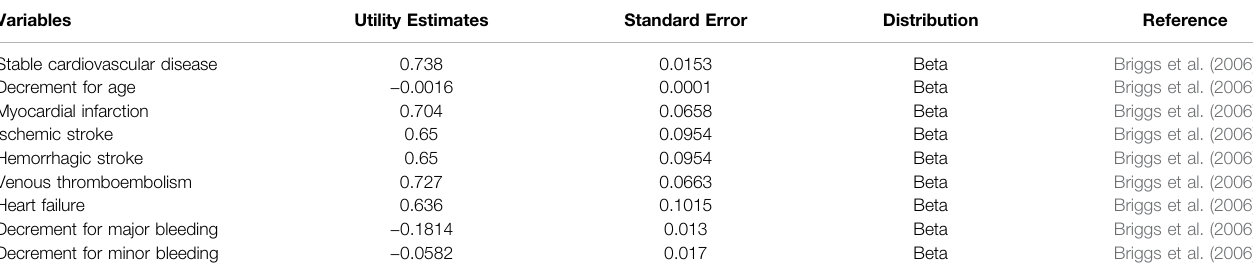
TABLE 3 | Input parameters for the